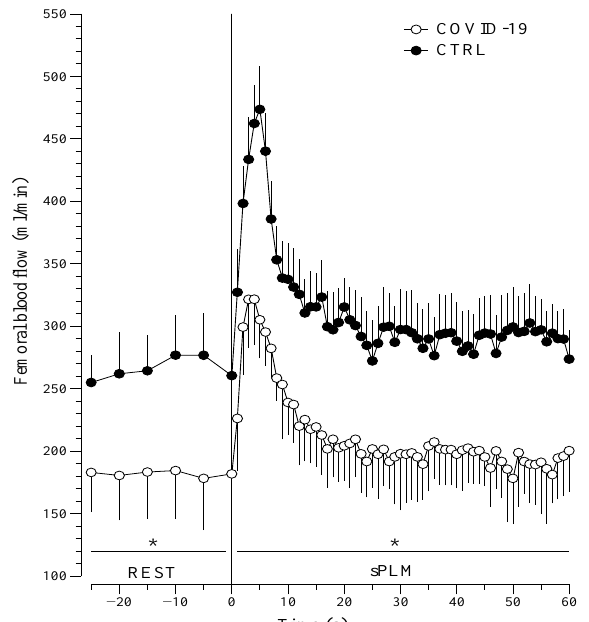
Figure 2. Hyperemic response to sPLM in COVID-19 and CTRL. Legend: Femoral blood flow in response to single passive leg movement in patients with COVID-19 ( n = 22) as well as in age- and sex-matched controls (CTRL, n = 22). Data are presented as mean ± standard error (SE). * p = 0.001, interaction of group × time (2-way ANOVA).